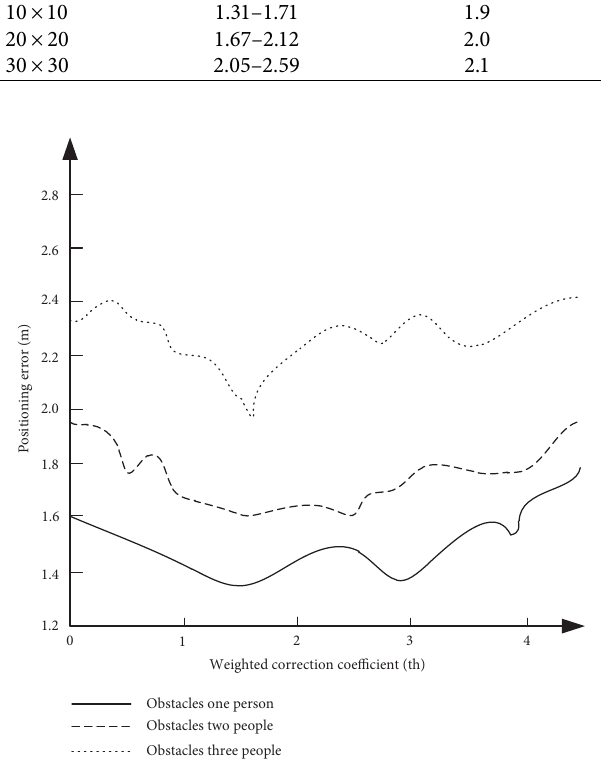
Figure 9: Obstacle impact